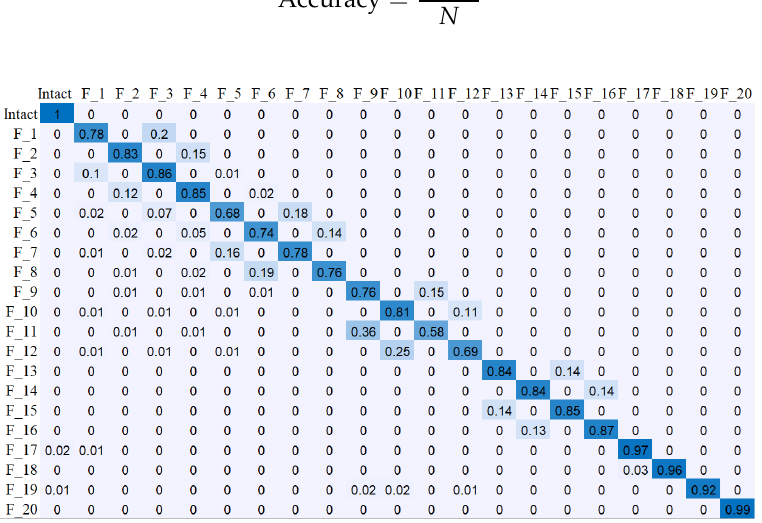
Figure 11. Failure detected location when there are 3 sensors at points 2, 5, and 8 (Accuracy: 84.1%).